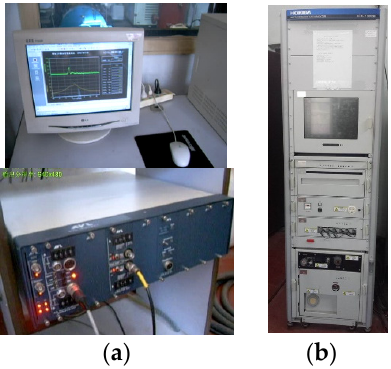
Figure 2. Major measurement apparatus: ( a ) AVL Indiset 620 combustion analyzer; ( b ) Horiba 7100 exhaust gas analyzer.